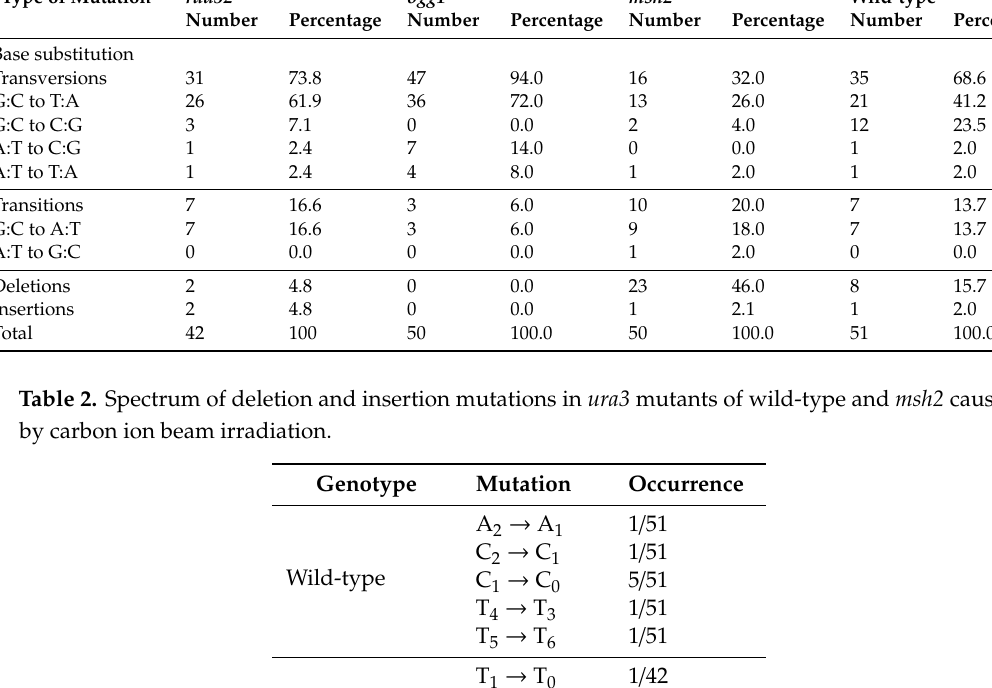
Table 1. Types of mutations induced by carbon ion beam irradiation (linear energy transfer [LET] 107 keV / um). Data for the wild-type (S288c strain) was taken from our previous report [12]. Type of Mutation rad52 ogg1